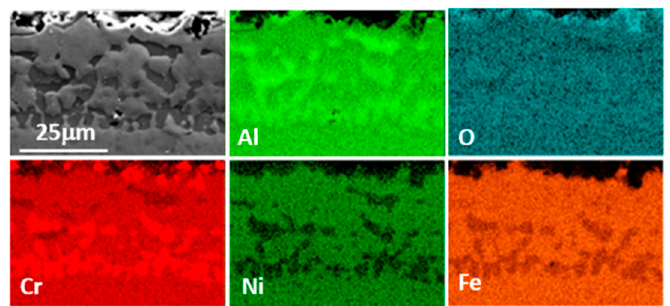
Figure 3. FESEM cross section and element map of the external layer (zone 1 in Figure 1) of the slurry aluminide coating deposited on HT347HFG steel.